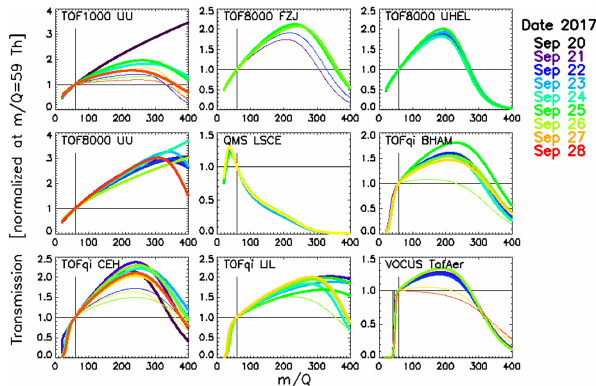
Figure 3. Retrieved transmission for all PTR-MS instruments (ex- cept the PTR3 instrument). Thin lines represent measurements at E/N below 150Td for the Vocus and below 100Td for all other instruments. The colours indicate the date of the